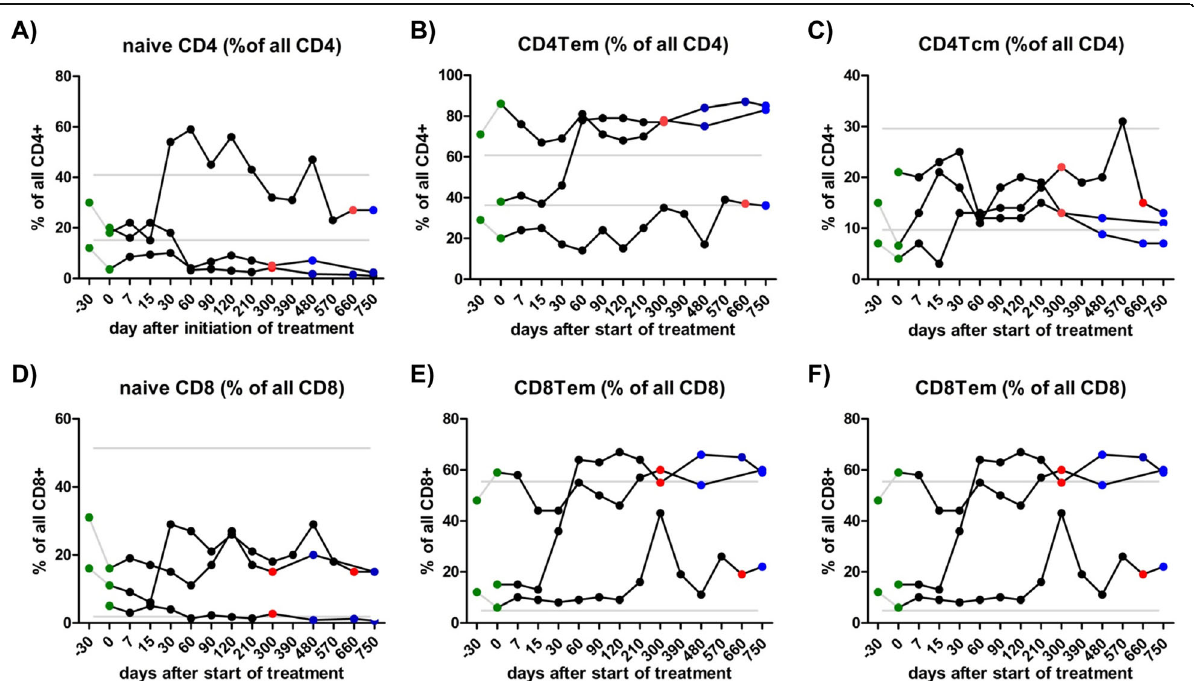
Fig. 2 High heterogeneity in CD4 / CD8 T cell subsets with no obvious alteration by ATRA. Central memory CD4+ T cells (CD4+ Tcm), naïve CD4+ T cells and effector memory CD4+ T cells (CD4+ Tem) as well as central memory CD8 T cells (CD8+ Tcm), naive CD8+ T cells and effector memory CD8+ T cells (CD8+ Tem) were tested before (green dots), during (black dots) and in the follow-up period after (blue dots) treatment with ATRA, red dots indicate end of treatment. High heterogeneity was observed with no evidence of direct alteration by induction of treatment. Grey lines indicate range of normal values (mean +/ − 2*SD) obtained as reference from 10 healthy controls. All tests showed no significance ( p < 0,05) in Friedman-test with Dunn ’ s post-hoc